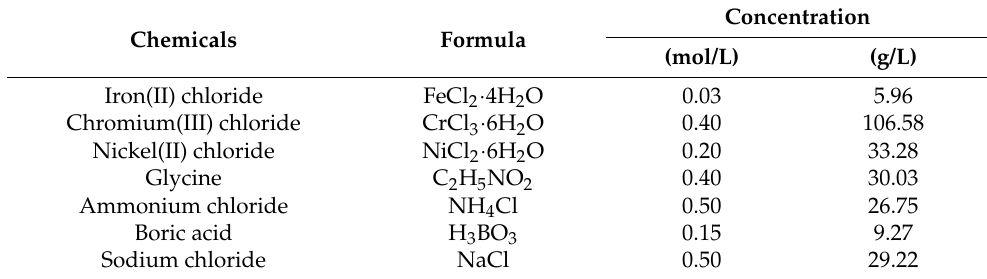
Table 1. Electrolyte